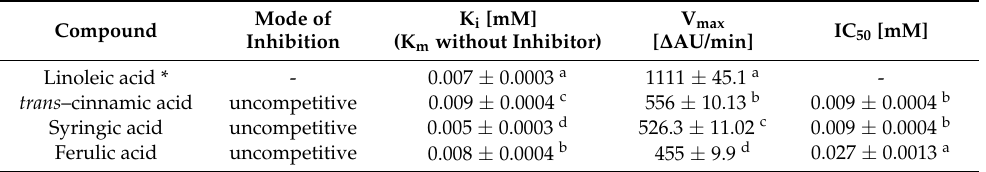
Table 2. Mode of inhibition, K i (K m without inhibitor), V max and IC 50 values of chosen phenolic acids on lipoxygenase (LOX)